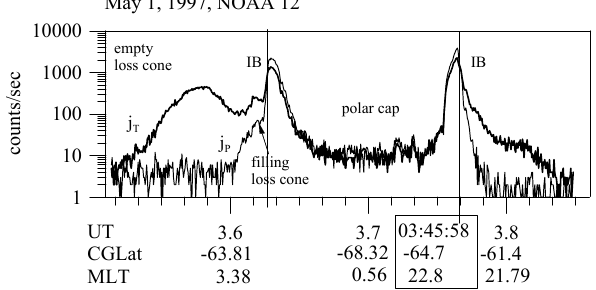
Fig. 1. Example of NOAA 12 measurements on 1 May 1997 show- ing the sharp boundaries marked by vertical lines when precipitating particle fluxes ( j P ) in the central part of the loss cone and locally trapped particle fluxes outside the loss cone ( j T ) become compara- ble.